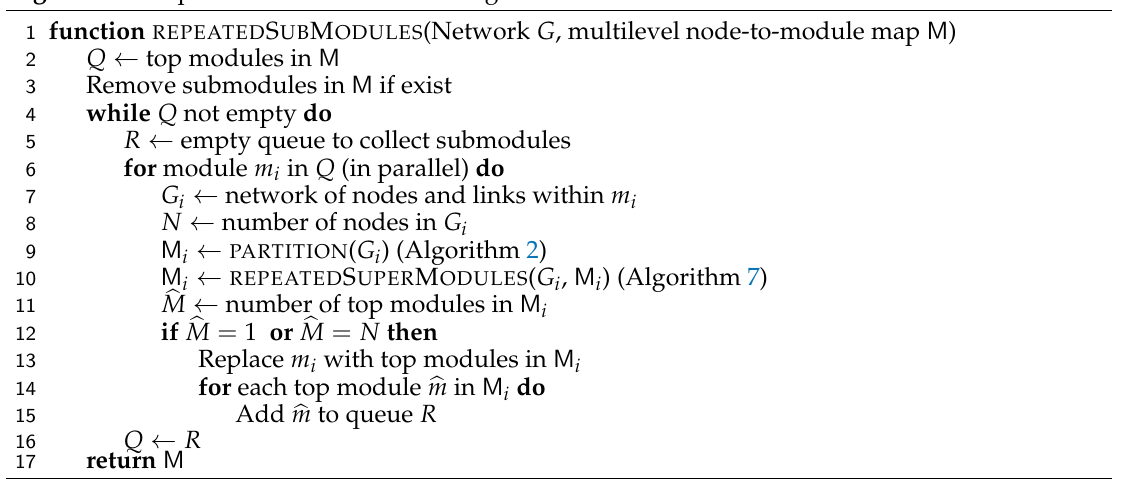
Algorithm 8 Repeated submodule